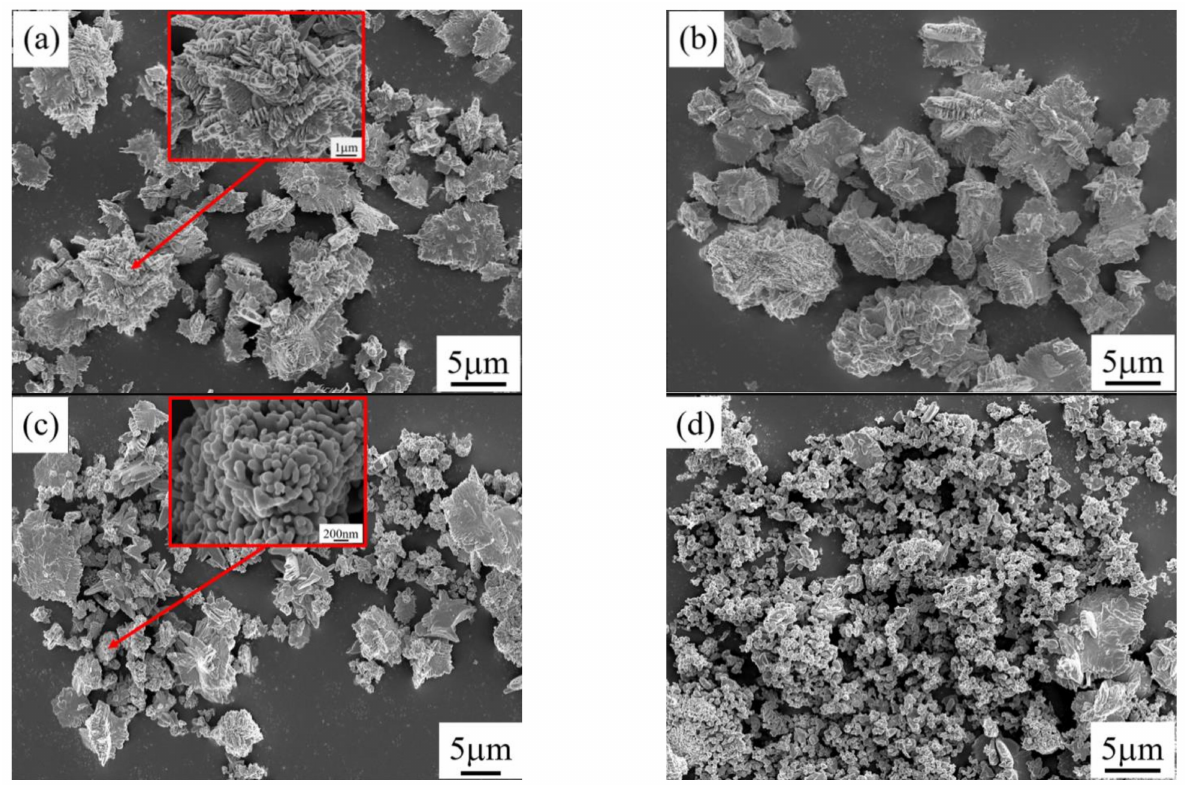
Figure 11. SEM images of pure copper precursor powders calcined at different temperature for 2 h: ( a ) 300 ◦ C; ( b ) 400 ◦ C; ( c ) 500 ◦ C; ( d ) 600 ◦ C. Cu-10 wt%W and Cu-30wt%W calcined powders at 500 ◦ C and 600 ◦ C for 2 h